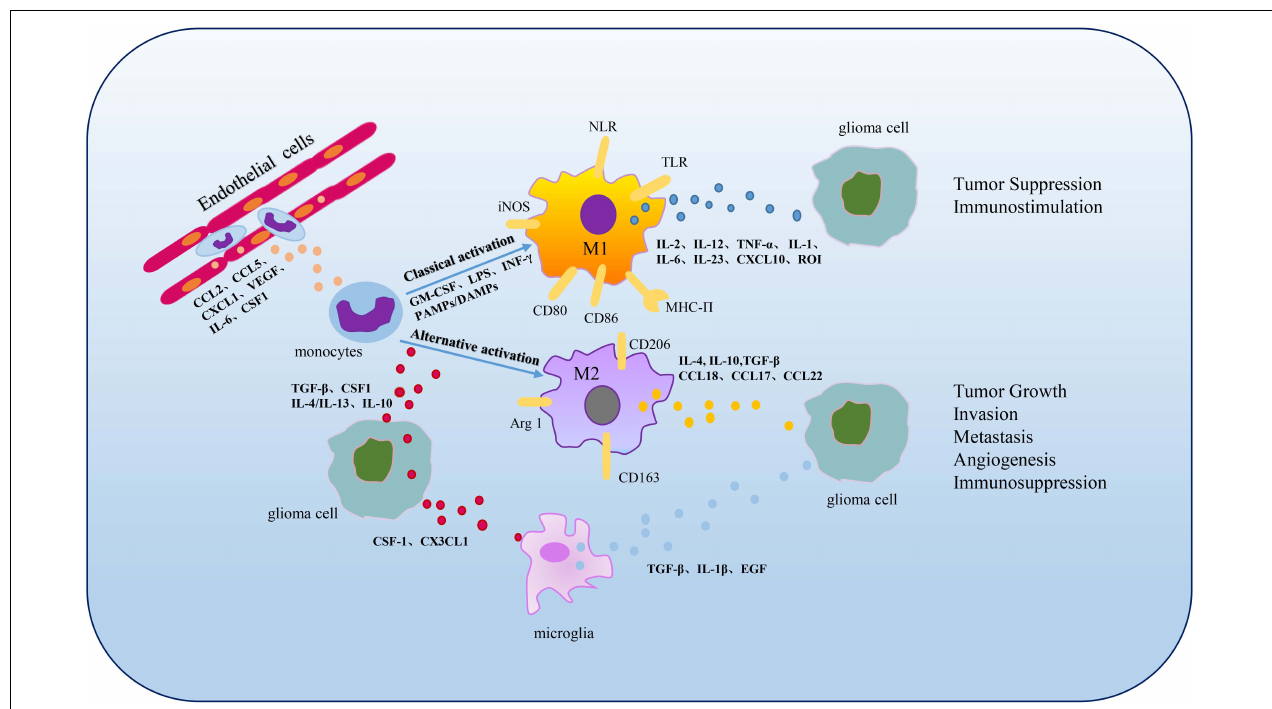
FIGURE 2 | Polarization and functions of GAMs. In the TME, when the BBB is impaired, monocytes infiltrate into tumors and can be differentiated into macrophages stimulated by cytokines involving CSF1, CCL2, CCL5, etc., (Chen and Hambardzumyan, 2018). M1 and M2 phenotypes are the two primary subpopulations of TAMs. M1 phenotype can be activated by cytokines such as GM-CSF, LPS, INF- γ or PAMPs/damage associated molecular patterns (DAMPs) and characterized by secretion of IL-2, IL-12, TNF- α , IL-1, IL-6, IL-23, CXCL10 and ROI, functioning in tumor suppression and immunostimulation (Lee et al., 2020; Xu et al., 2020). M2 phenotype can be activated by cytokines including TGF- β , CSF1, IL-4, IL-13 or IL-10 and secrete large amounts of IL-4, IL-10, TGF- β , CCL18, CCL17 and CCL22, contributing to tumor growth, invasion, metastasis, angiogenesis and immunosuppression (Xu et al., 2020). Microglia, the resident macrophages in CNS, can